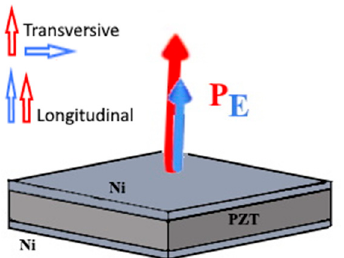
Figure 1. Schematic diagram of the